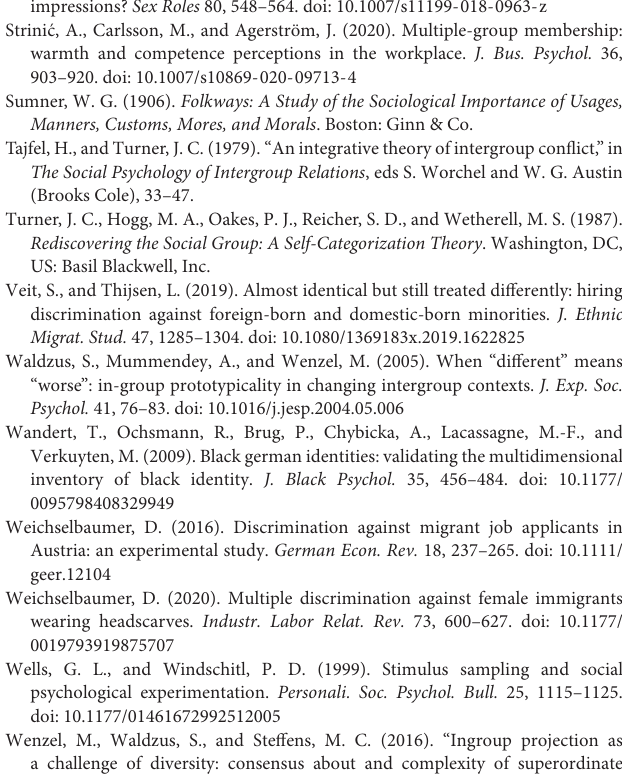
Table Population, Share of Female Population] . Available online at: